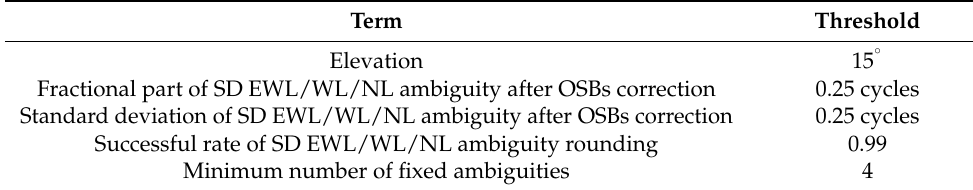
Table 1. Quality control strategies for UCPPP AR. Term Threshold Elevation 15 ◦ Fractional part of SD EWL/WL/NL ambiguity after OSBs correction 0.25 cycles Standard deviation of SD EWL/WL/NL ambiguity after OSBs correction 0.25 cycles Successful rate of SD EWL/WL/NL ambiguity rounding 0.99 Minimum number of fixed ambiguities